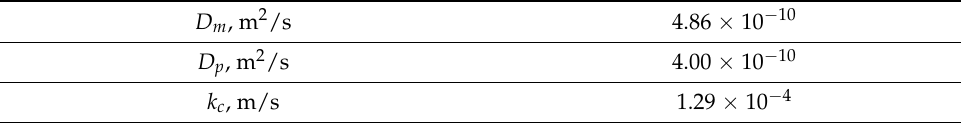
Table 6. Ammonium sulfate mass transfer parameters.